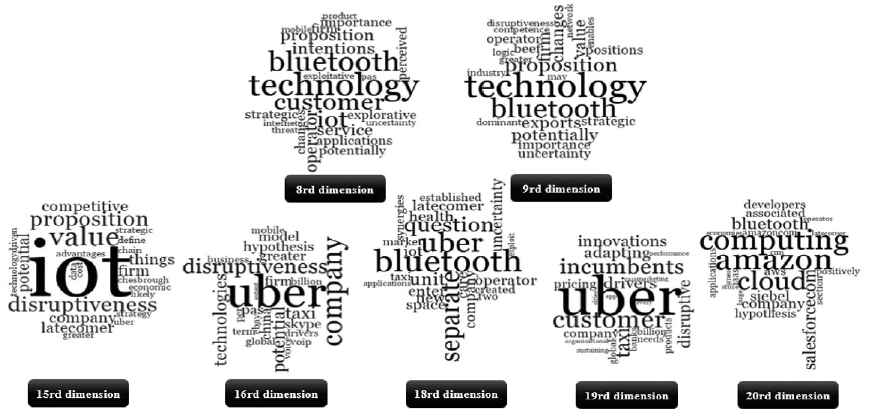
Figure 8. The 8th, 9th, 15th,